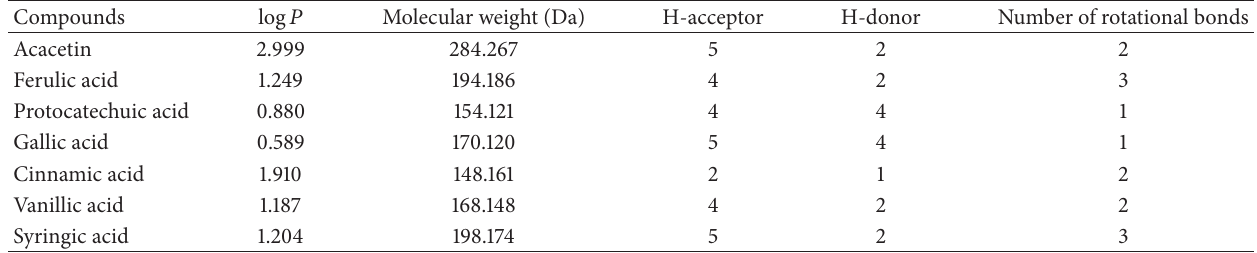
Table 3: Physiochemical descriptors of the polyphenolic compounds.